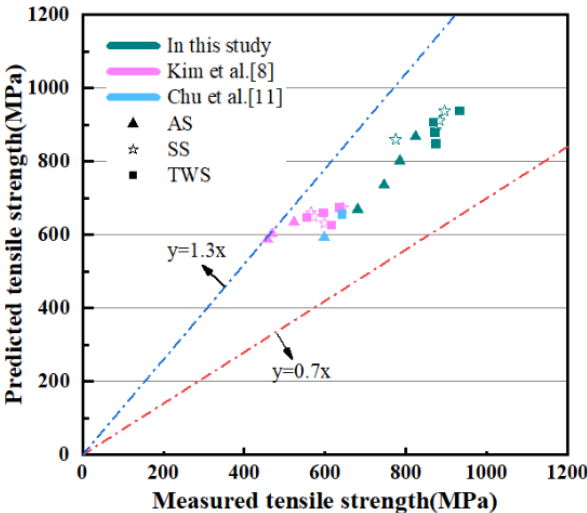
Figure 9: Relationship between predicted tensile strength and measured tensile strength of conditioned GFRP bars